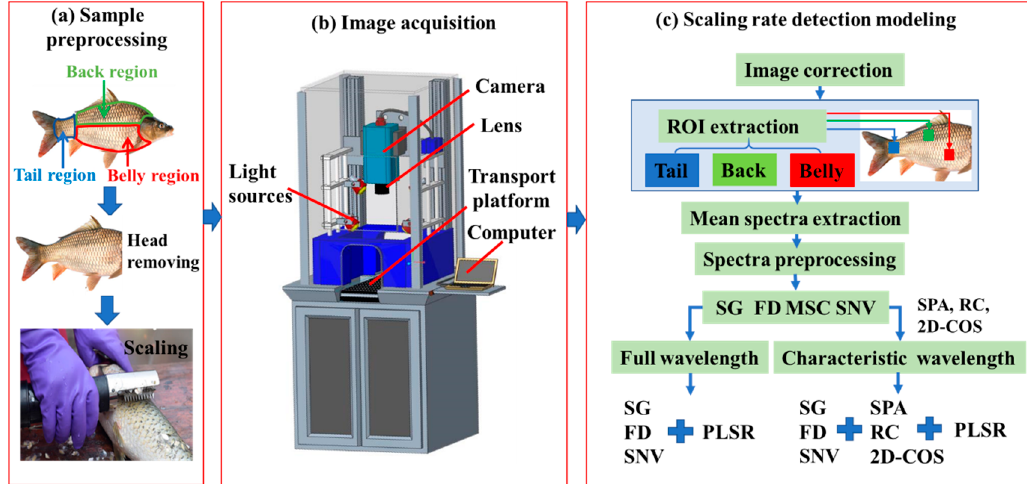
Figure 1. Experimental procedure. (ROI: region of interest, SG: Savitzky–Golay, FD: first derivative, MSC: multiple scattering correction, SNV: standard normal variate, SPA: successive projection algorithm, RC: regression coefficient, 2D-COS: two-dimensional correlation spectroscopy, PLSR: partial least square regression.)